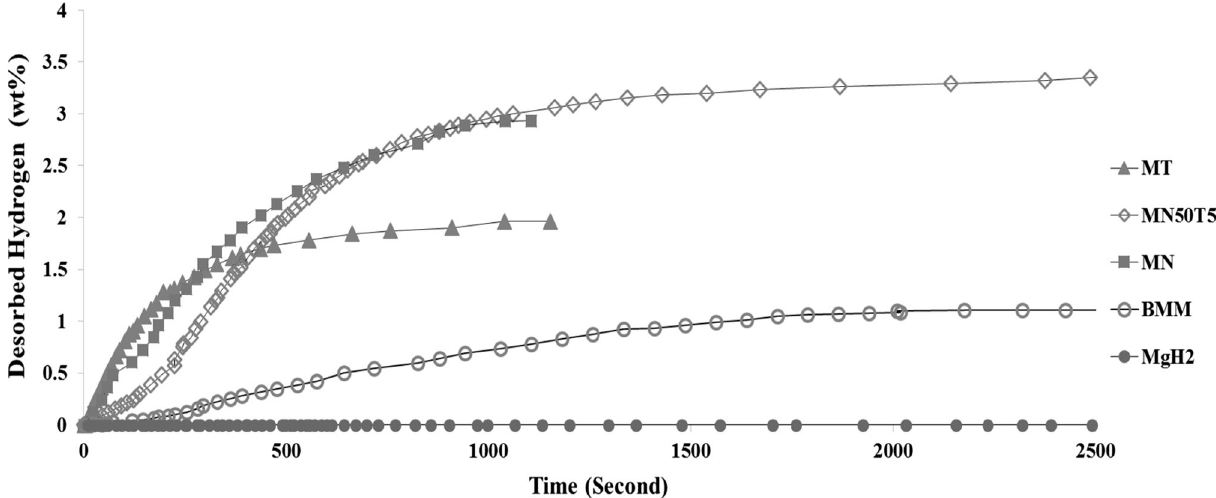
Fig. 5 Hydrogen desorption results of MgH 2 , MT, MN and MN50T50